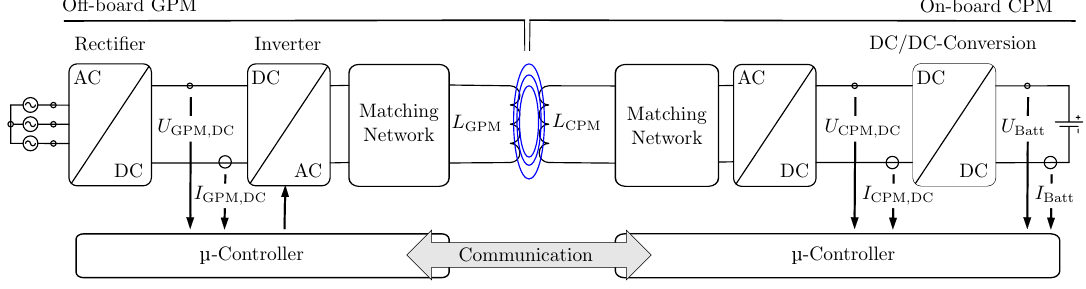
Figure 1. Exemplary wireless power transfer